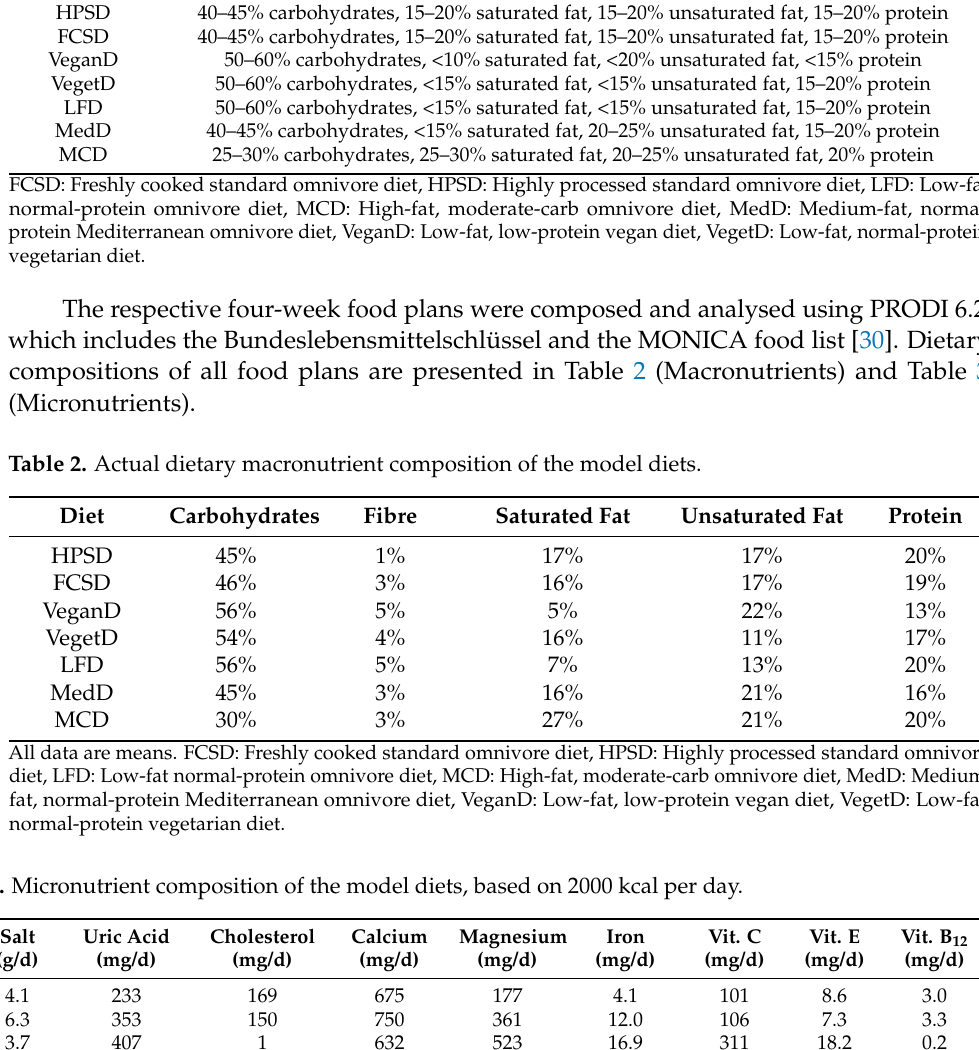
Table 1. Dietary targets for the model diets. Diet Dietary Goals HPSD